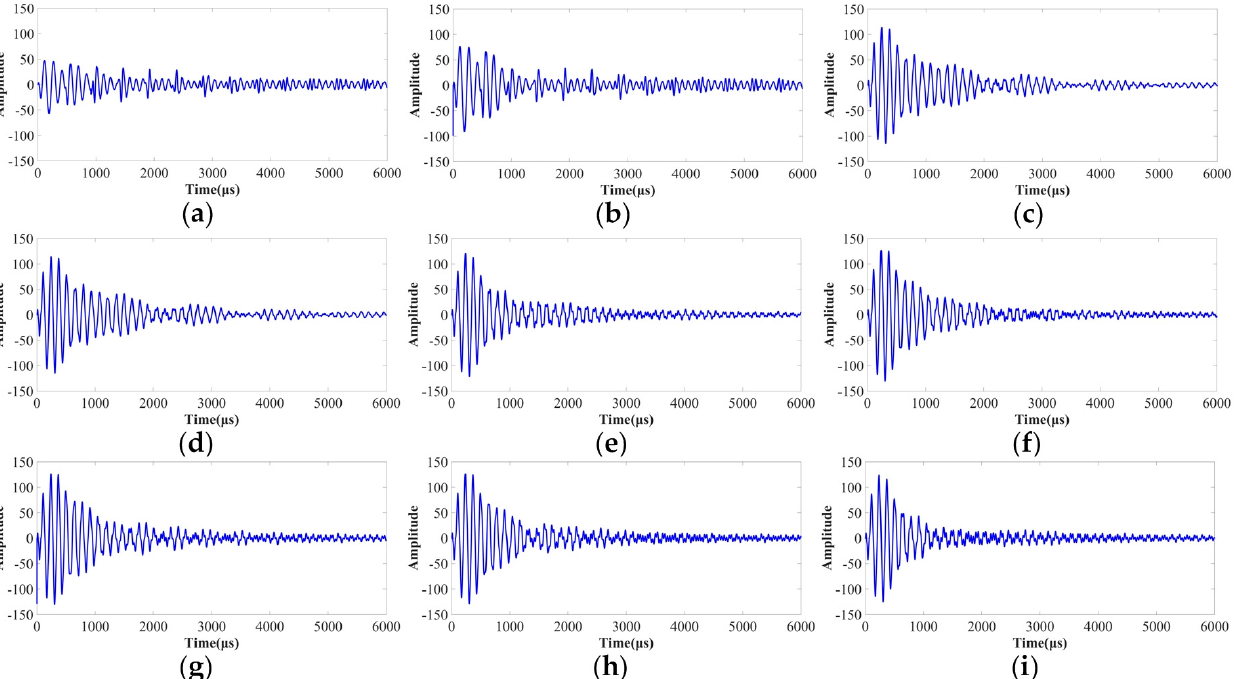
Figure 9. Time domain diagrams of the stress wave signal at different stages of bolt tension. ( a ) Unstretched; ( b ) Elastic stage; ( c ) Yield stage; ( d – f ) Strengthening stage; ( g – i ) Necking fracture stage.